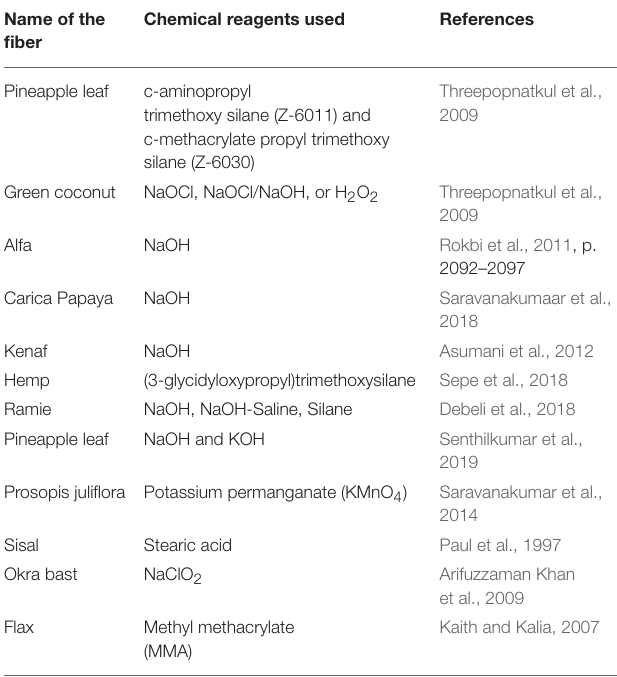
TABLE 1 | Chemical treatments for different natural fibers. Name of the